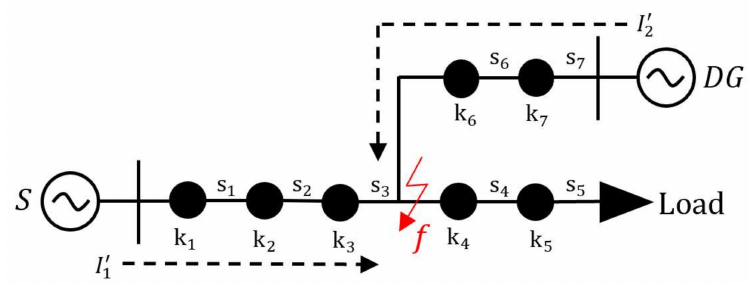
Figure 1. Multi-power distribution network